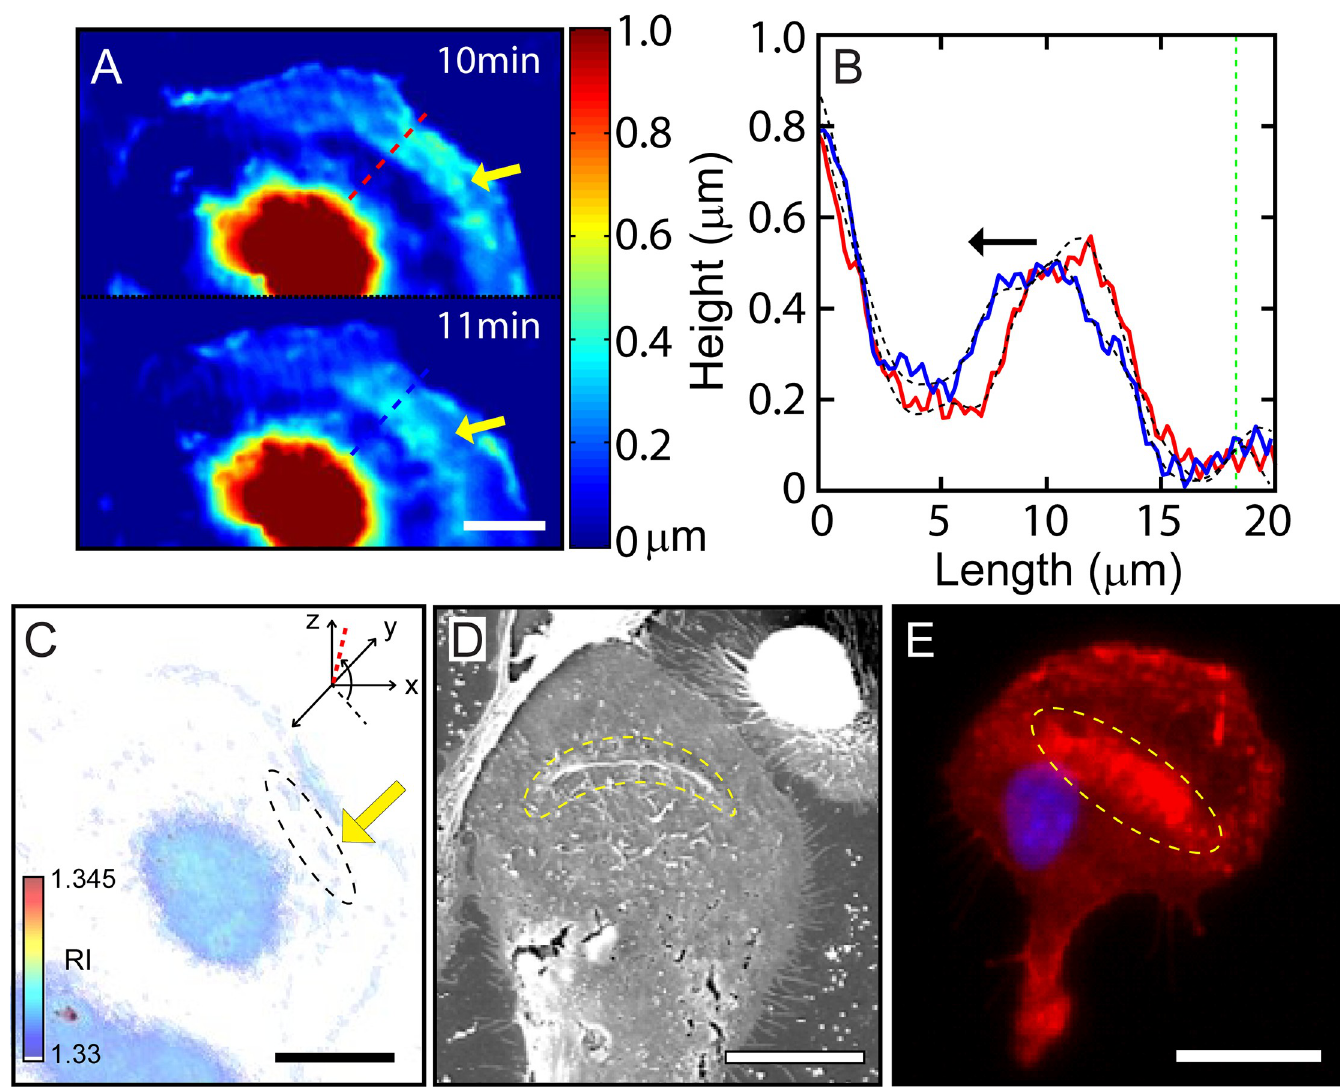
Fig 4. Quantification of periodic dorsal-fin shaped waves. A) Phase image of SAM showing dorsal-fin shaped ruffle in the lamella indicated by yellow arrows. B) 1-D plot of cell surface from bottom showing along the red and blue dotted lines drawn in (A). Black-dotted lines show smoothed values using a low-pass filter with 6 points and green dotted line represents a cell boundary. Black arrow denotes the direction of dorsal wave propagation. C) An isosurface image of 3-D rendered of RI tomogram (see Visualization 5). Black dotted area and yellow arrow indicate the dorsal fin-shaped ruffle in the lamellipodium region (Tomogram displays the viewpoint with azimuth and elevation to -137 º and 84 º , respectively). D) SEM image shows dorsal wave formed in the middle of lamella in the fixed microglia indicated yellow dotted area. E) FM image representing stained by DAPI (blue) and Phalloidin (red) for nucleus and F-actin, respectively. The yellow dotted area indicates the region of concentrated F-actin. Scale bars in A) and C) are 10 μ m. They are 20 μ m in D) and